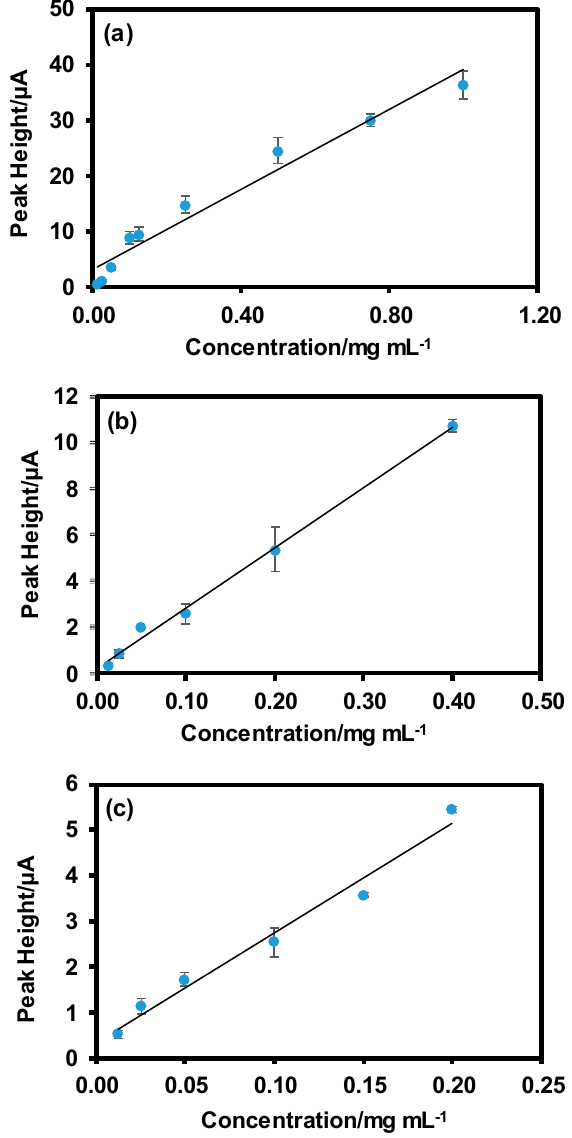
Figure 2. Calibration curve depicting the signal intensity versus concentration for: ( a ) Bare GONC material; ( b ) GONC-dsDNA conjugate obtained by physical adsorption; (c) GONC-dsDNA conjugate obtained by covalent